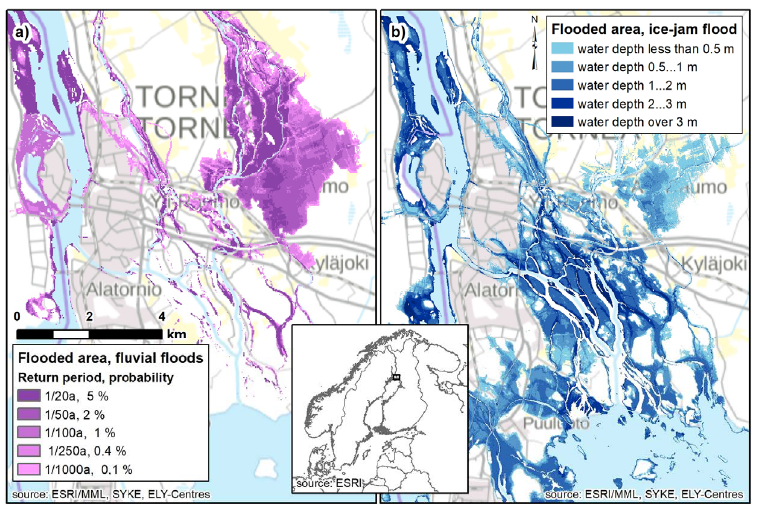
Figure 5. Flood extent for ( a ) different fluvial flood probabilities and ( b ) a severe ice-jam flood (flow = 3100 m 3 /s and + 2m sea water level) at the Torne River outlet. (source: SYKE). (flow = 3100 m 3 /s and +2 m sea water level) at the Torne River outlet. (source: